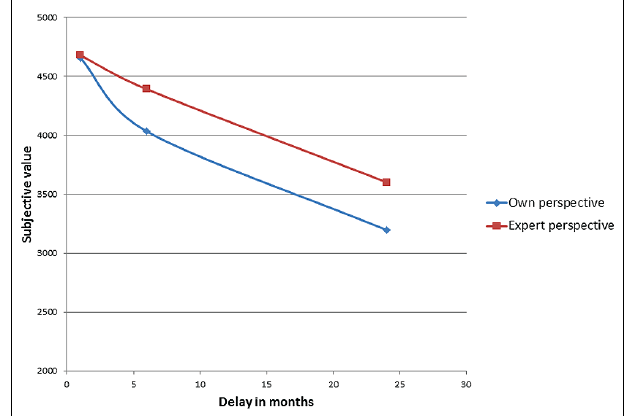
FIGURE 4 | Discounting curves for delayed gains.